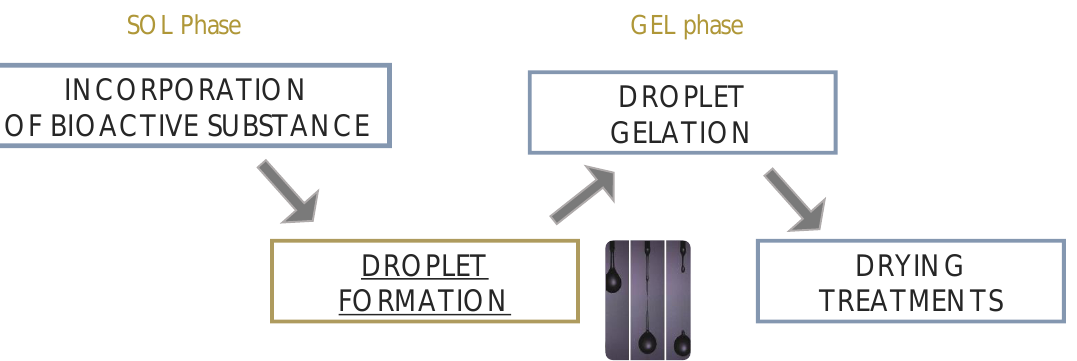
Figure 1. Illustration of the general way for producing hydrogels in form of particles: transition from polysaccharide solution (SOL phase) to a gel particle (GEL phase) followed by possible drying treatments.